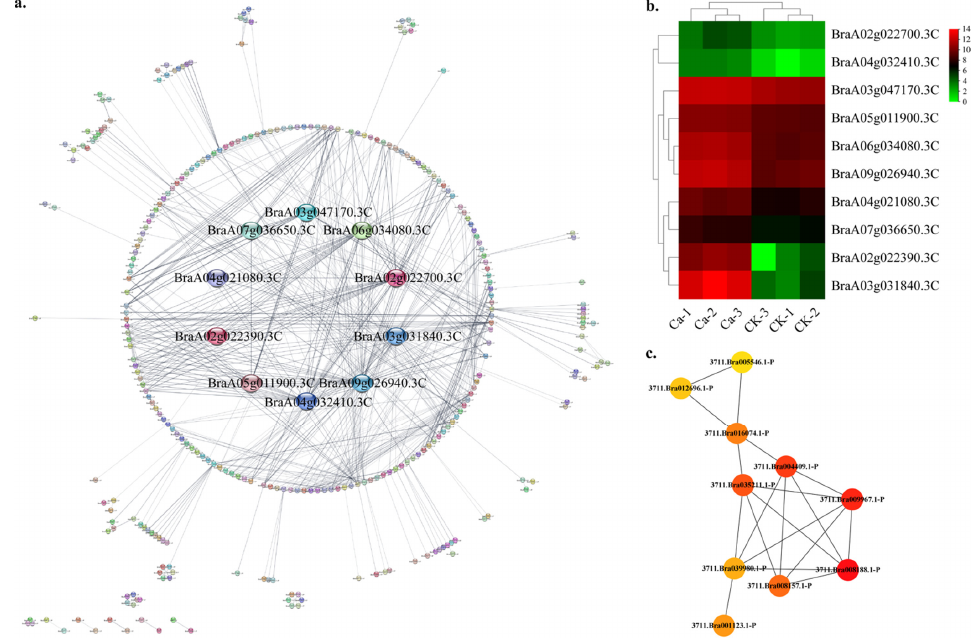
Figure 7. Protein–protein interaction (PPI) analysis in stress-related DEGs category. ( a ) PPI network in stress category. ( b ) Heatmap of the hub gene expression pattern. ( c ) Hub genes’ interactive relationship of the gene regulatory network.